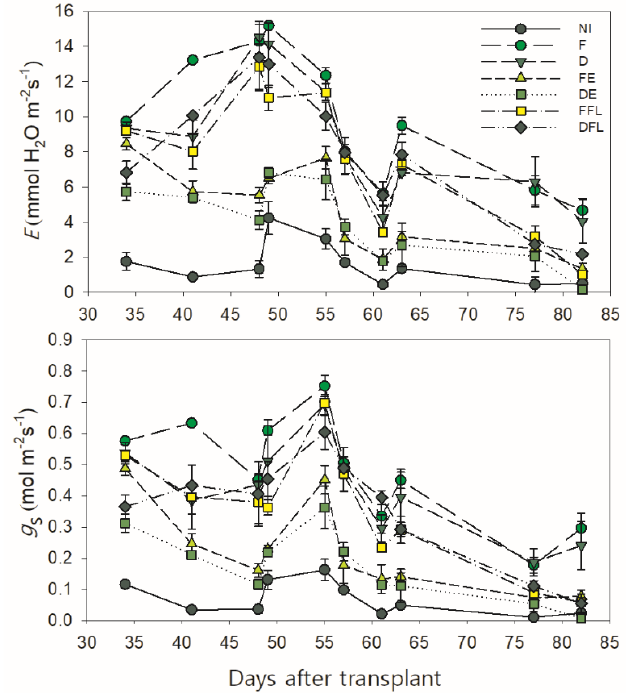
Figure 3. Course of leaf transpiration ( E , mmol H 2 O m − 2 s − 1 ) and stomatal conductance ( g s , mol m − 2 s − 1 ) during the growth period in processing tomatoes cv. Hypeel F1 under di ff erent